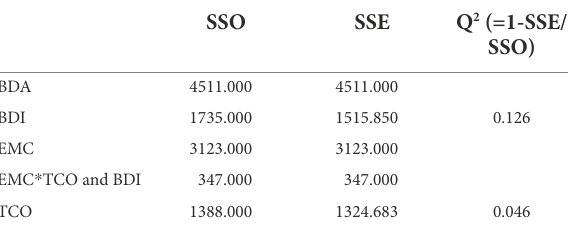
TABLE 8 Q 2 for model predictive relevance.